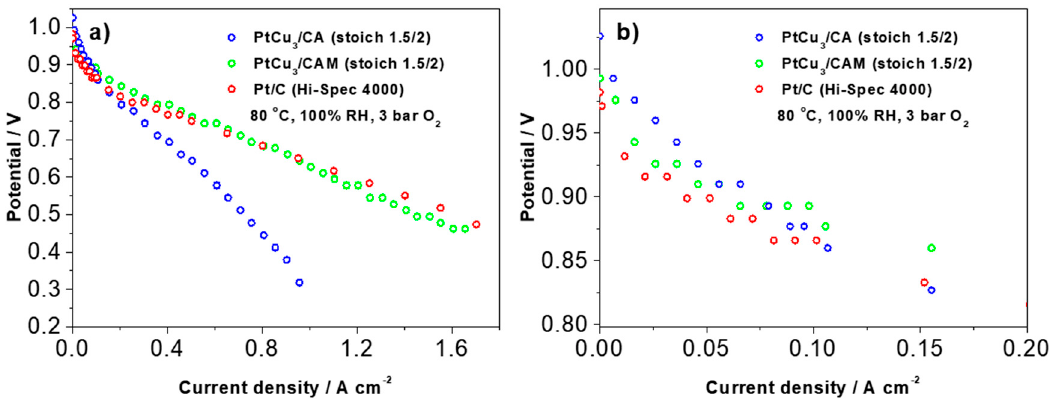
Figure 4. ( a ) Polarization measurement of PtCu 3 / CA, PtCu 3 / CAM analogues, and Pt / C reference (Hi-Spec 4000), as well as ( b ) a close-up of the low current density region at 80 ◦ C, 100% RH, and 3 bar O 2 pressure (H 2, stoich = 1.5; O 2, stoich = 2.0). The curves are not corrected for IR drop. Pt loadings at anode and cathode: 0.2 mg Pt / cm 2 . Membrane: 20 µ m SSC PFSA Aquivion.